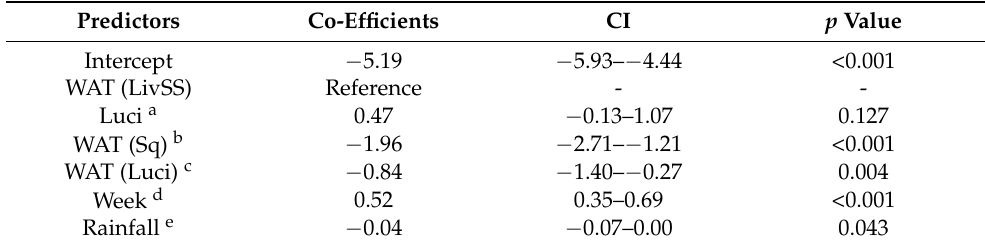
Table 6. Summary of model coefficients, confidence intervals and p values for each predictor of the rate of catch per week of Lucilia cuprina . The rate of catch per week model included an offset of the bycatch (i.e., all other flies other than L. cuprina and L. sericata ) in each trap.